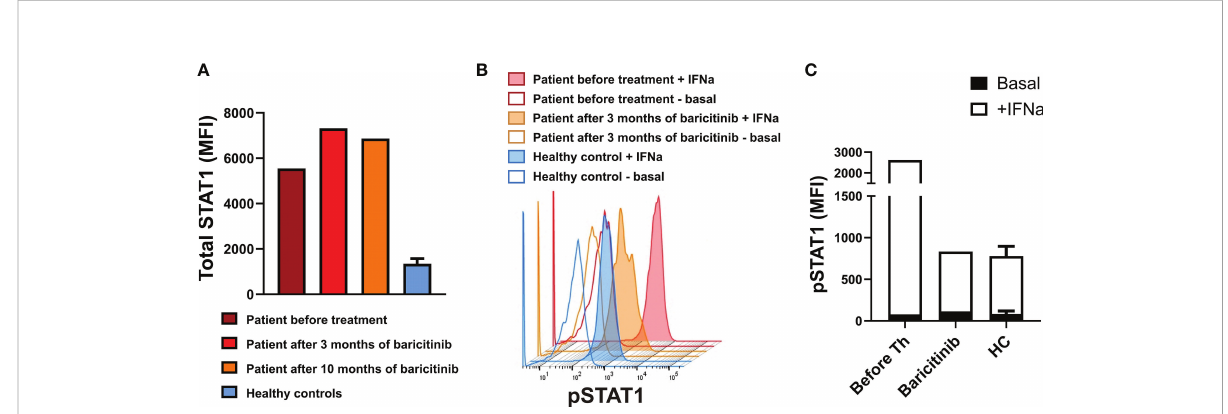
FIGURE 2 (A) : Total STAT1 levels in CD4+ T lymphocytes from the patient on indicated time points and healthy controls. (B) Phosphorylated STAT1 (pSTAT1) levels in unstimulated whole-blood CD4+ T lymphocytes and on interferon (IFN)- a induction. (C) Basal (unstimulated) pSTAT1 levels and pSTAT1 levels on stimulation with IFN- a for 15 minutes in CD4+ T lymphocytes from the patient before treatment and after 3 months of baricitinib, and from healthy controls. Values in (A) and (C) for healthy controls ( n =3) are the mean ± SD. MFI, median fl uorescence intensity; HC, healthy